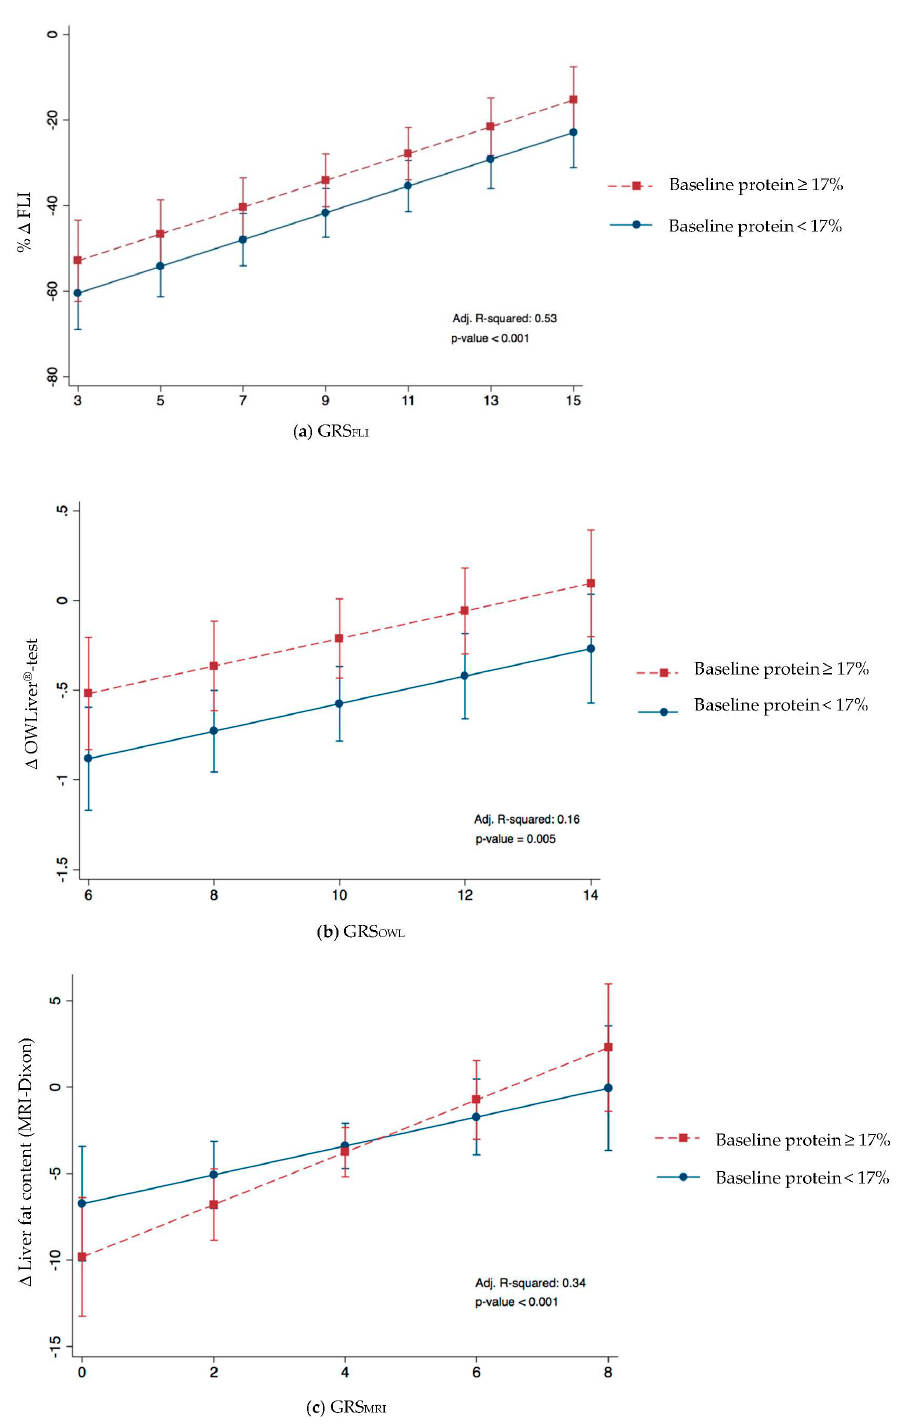
Figure 2. Effect of the changes in ( a ) % FLI and GRS FLI , ( b ) OWLiver ® -test and GRS OWL and ( c ) MRI and GRS MRI and baseline protein after 6-month nutritional treatment. Baseline protein was dichotomized according to median.